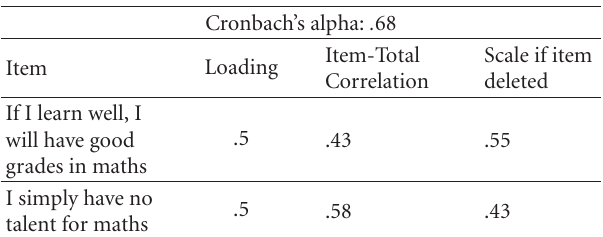
Table 4: Self-e ffi